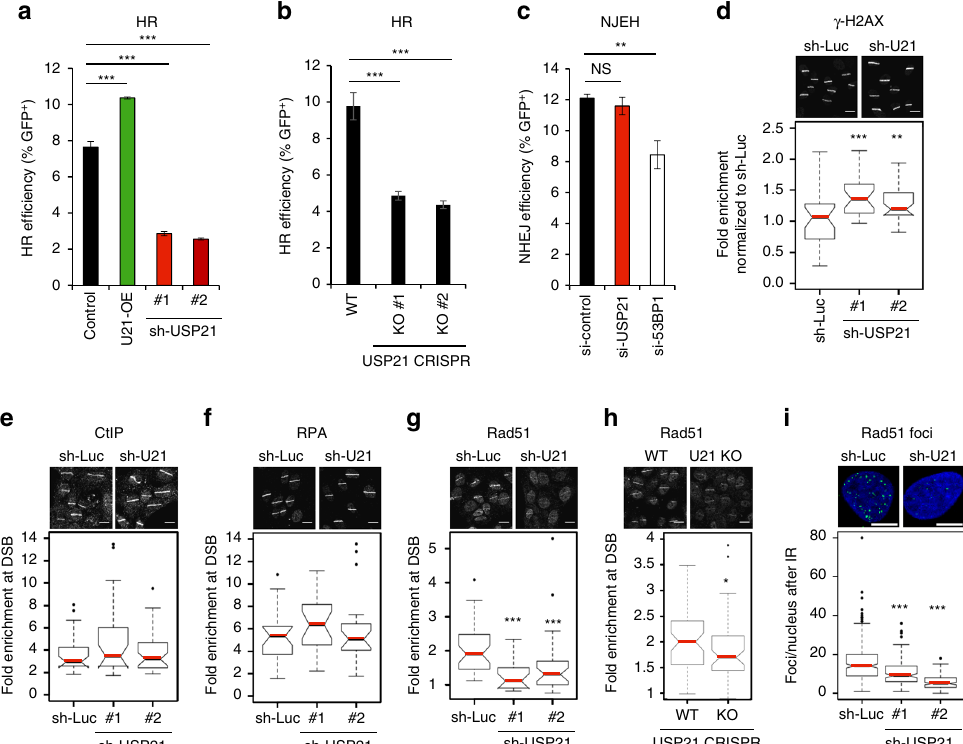
Fig. 1 USP21 promotes HR by facilitating RAD51 accumulation at DSBs. a HR ef fi ciency in TRI-DRGFP reporter cells in the presence of the indicated shRNAs or transient USP21 overexpression. One of at least three representative experiments is shown. b HR ef fi ciency in control (WT) TRI-DRGFP cells and two independent CRISPR/Cas9 USP21 knockout (KO) clones. c NHEJ ef fi ciency in pEJ5-GFP-transgenic U2OS cells transfected with the indicated siRNAs. Values in a through c are expressed as mean and s.d. and samples were analyzed in triplicate. d – h Immuno fl uorescence (IF) analyses at laser-induced DSBs in U2OS cells 1 h after release from double-thymidine-block. Representative images are shown, scale bar : 20 µ m. For box plots , bottom and top hinges denote fi rst and third quartile, respectively. Whiskers denote ± 1.5 interquartile range (IQR). The red horizontal line represents the median. p -values are based on a two-sided Wilcoxon rank-sum test, sh-U21: sh-USP21. d γ -H2AX levels in cells expressing sh-Luc ( n = 30), sh-U21-1 ( n = 26) or sh-U21-2 ( n = 35). One of fi ve representative experiments is shown. Fluorescence intensity of γ -H2AX + areas was quanti fi ed and normalized to sh-Luc. e CtIP accumulation in cells expressing sh-Luc ( n = 28), sh-U21-1 ( n = 27) or sh-U21-2 ( n = 36). Fold enrichment re fl ects the ratio of γ -H2AX + over γ -H2AX – nuclear areas. f RPA accumulation at laser-induced DSBs as in e ; sh-Luc ( n = 23), sh-U21-1 ( n = 22), sh-U21-2 ( n = 23). g RAD51 accumulation at laser-induced DSBs as in e . One of fi ve representative experiments is shown, sh-Luc ( n = 30), sh-U21-1 ( n = 32), sh-U21-2 ( n = 37). h RAD51 accumulation as in g using control (WT, n = 60) and USP21 KO cells ( n = 55). i IF analysis of RAD51 foci 6 h after IR (10 Gy). Box plots represent the number of nuclear RAD51 foci ( green );